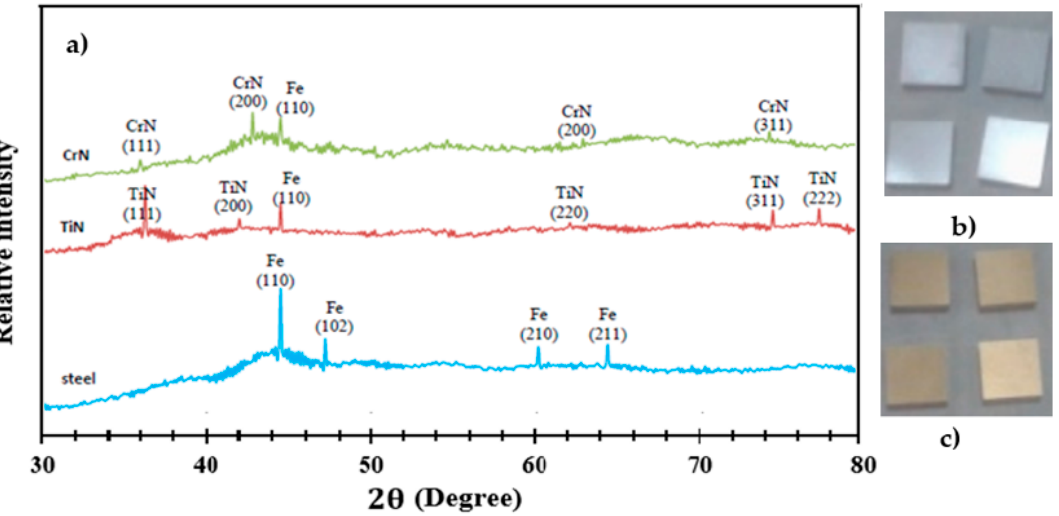
Figure 5. ( a ) XRD analysis results for coated and uncoated specimens, ( b ) TiN-coated samples, and ( c ) CrN-coated samples.